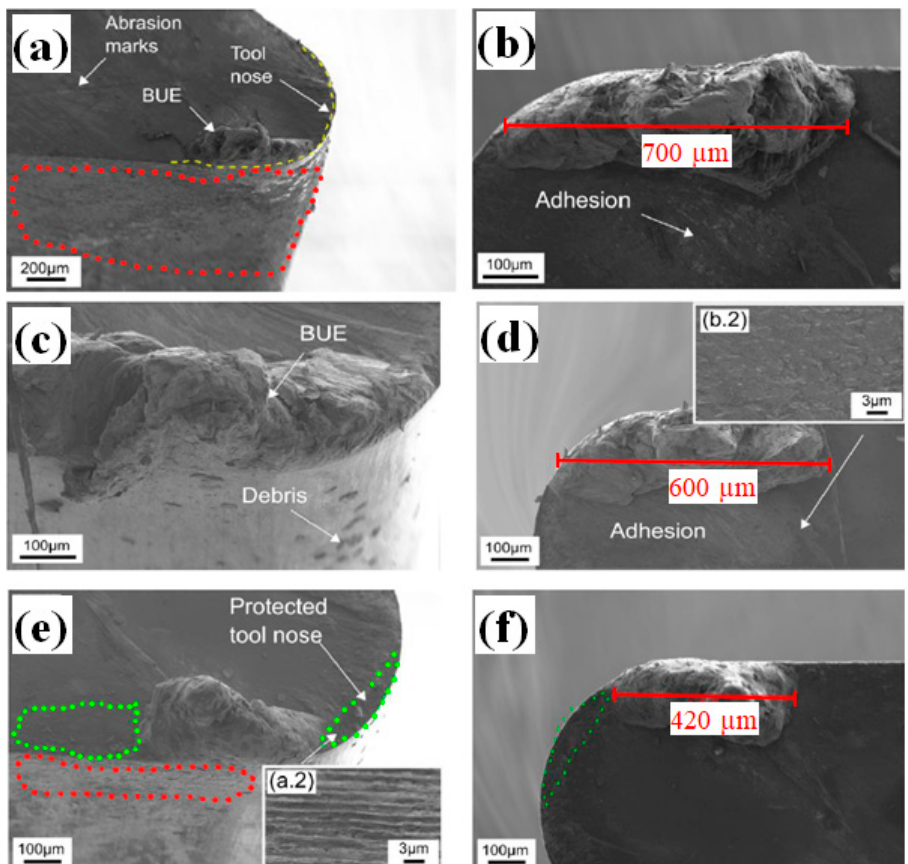
Figure 6. SEM images untextured tool tip for wear analysis: side view of rake-flank face at 25° tilting ( a ), enlarged image of rake face top view showing the BUE ( b ), textured tools with a spatial period of 2 µm: side view of tool tip and BUE formation of configuration 2 at 25° tilting ( c ), enlarged image of rake face top view showing the BUE for configuration 4 ( d ), textured tools with a spatial period of 5.5 µm: side view of tool tip and BUE formation of configuration 5 at 25° tilting ( e ), enlarged image of rake face top view showing the BUE for configuration 5 ( f ) .